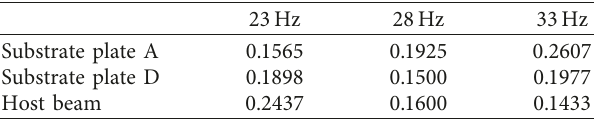
Table 8: Averaged velocity (m/s) of the nonlinear EMM system in 100seconds.